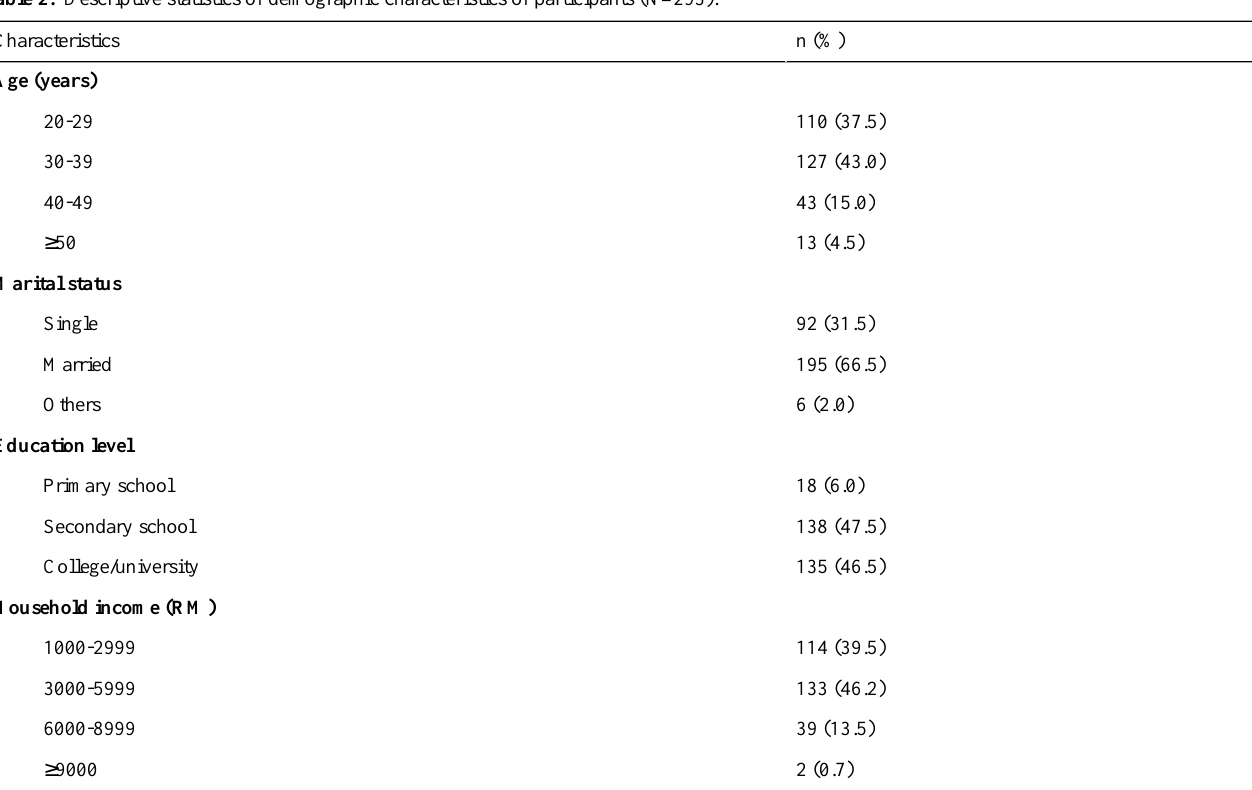
Table 2. Descriptive statistics of demographic characteristics of participants